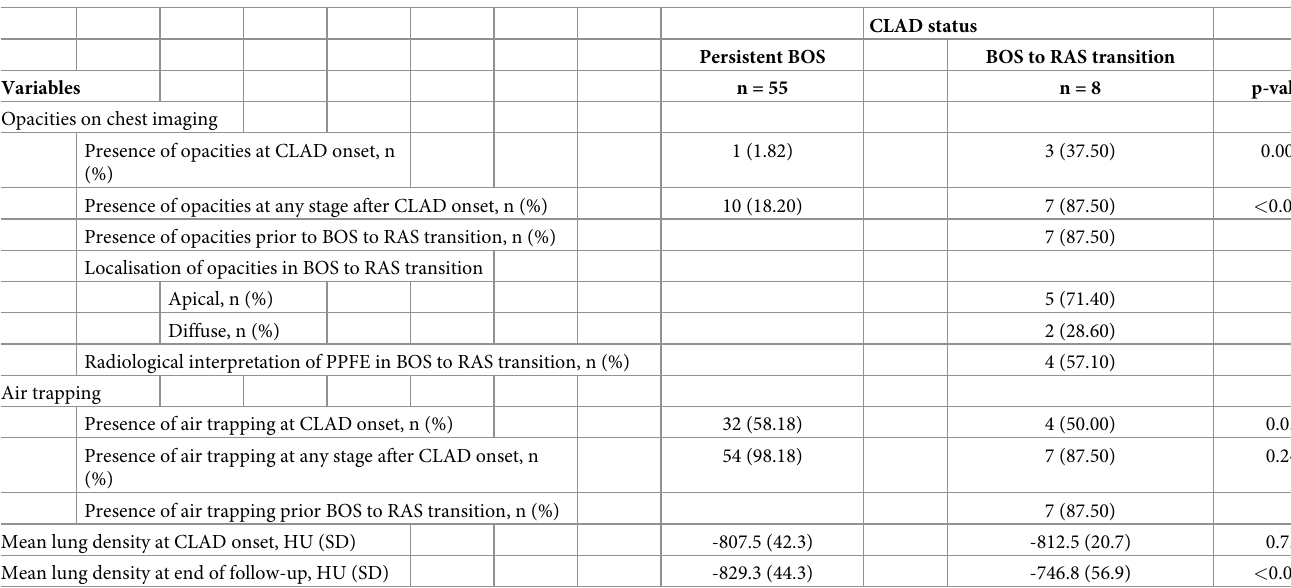
Table 3. Radiological